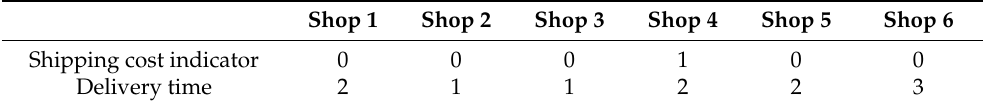
Table 5. Numerical solution results of the initial master